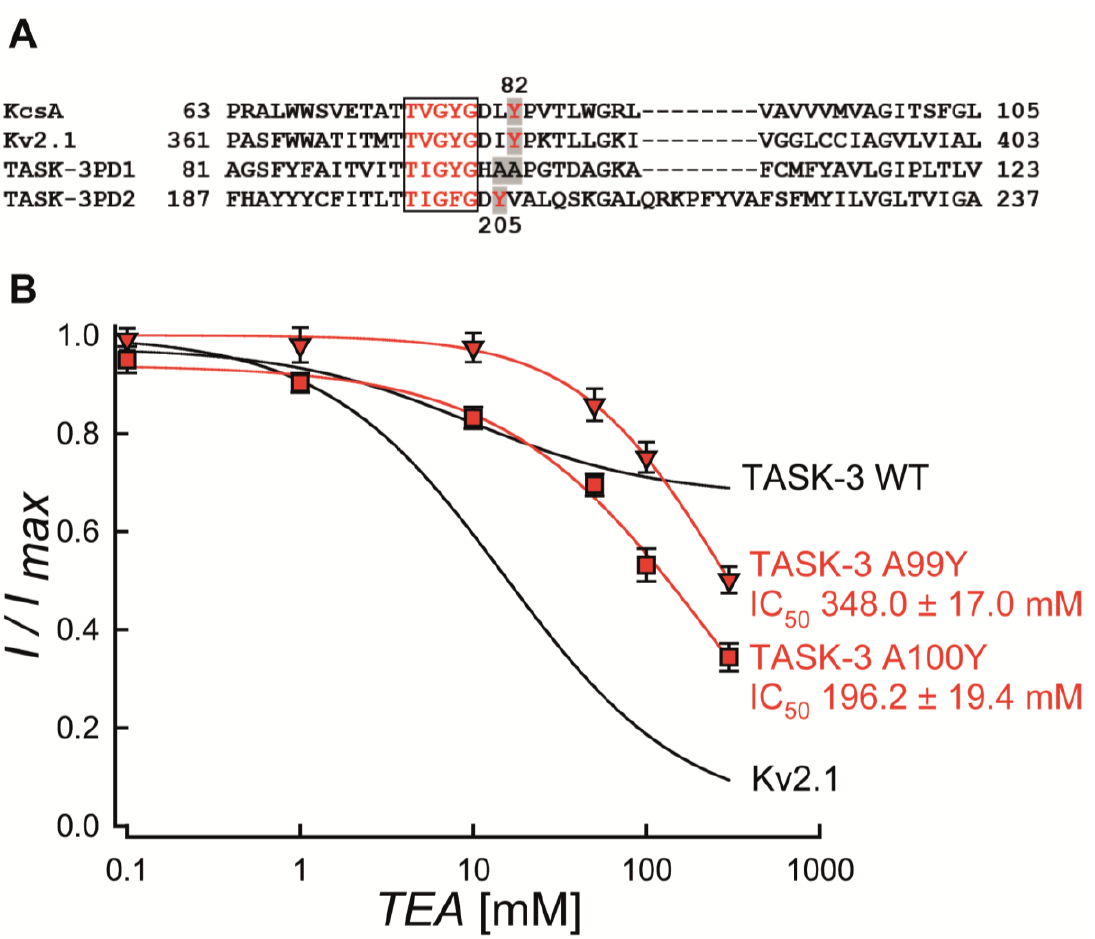
Figure 2. Multiple alignment of selected K + channel pore domains and effect of TEA on TASK-3 and Kv2.1 mutant channels expressed in HEK-293 cells. ( A ) Amino acid sequence alignment of KcsA, Kv2.1 and TASK-3 pore domains. Gaps are indicated by dashes, letters with gray background are the residues implicated in the TEA binding site (Y82, Y380, A99, A100 and Y205, respectively). The selectivity filter signatures are boxed and the numbers are indicated. The PD1 and PD2 signify pore domains 1 and 2 of TASK-3 channels, respectively. ( B ) Dose-response curve of TEA on A99Y (red triangle) and A100Y (red square) mutants. The block was analyzed at the end of the test pulse at +80 mV. Results are shown as means ± SEM. The black lines were taken from the fits in Figure 1C and correspond to the TEA inhibition curves for TASK-3 WT and Kv2.1, respectively.